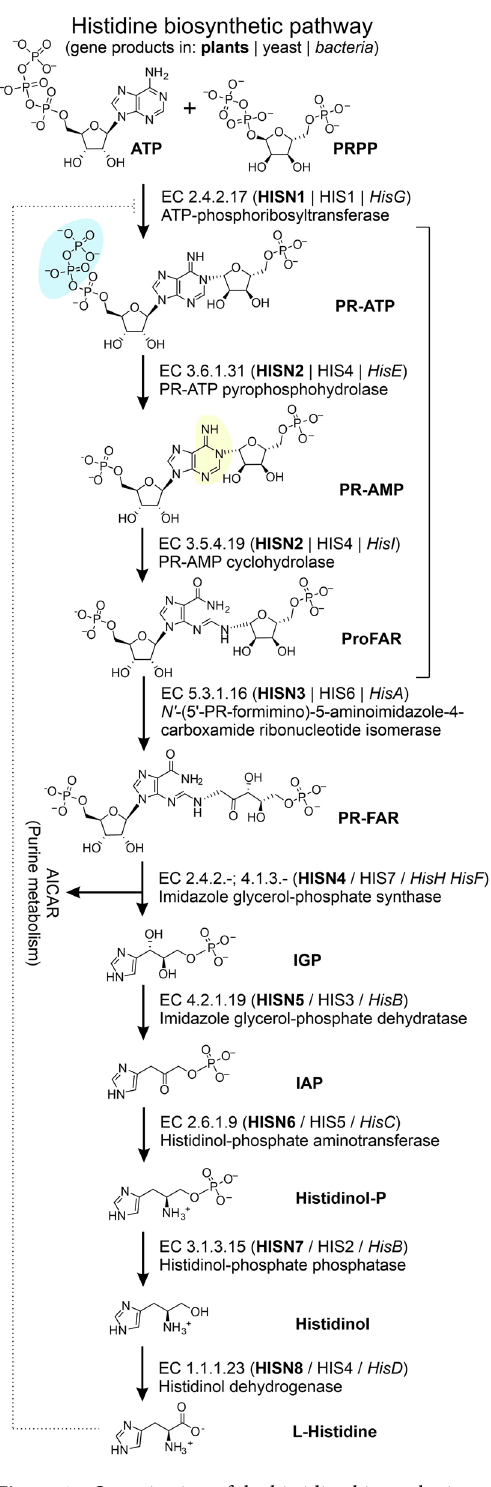
Figure 1. Organization of the histidine biosynthetic pathway (HBP) in plants, yeast, and bacteria. The large bracket marks the pathway fragment catalyzed by the PRA-PH and PRA-CH domains of Mt HISN2. Hydrolyzed groups by the PRA-PH and PRA-CH domains are highlighted by blue and yellow, respectively. The dotted line illustrates the feedback